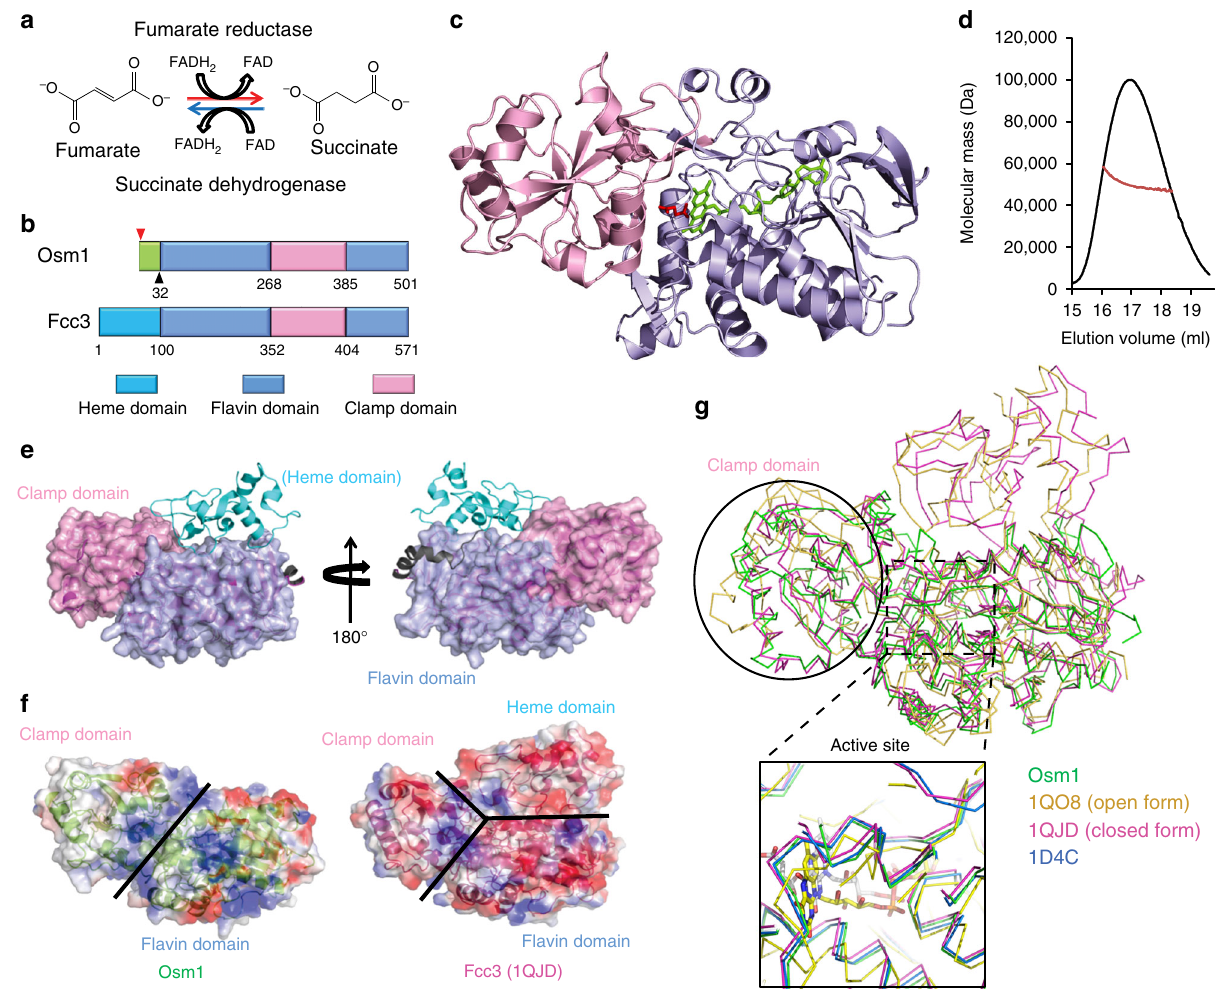
Fig. 1 Crystal structure of Osm1 in a complex with the FAD cofactor and substrate. a Schematic of the enzymatic reaction catalyzed by fumarate reductase. b Domain structure of Osm1 and a representative soluble fumarate reductase, Fcc3, from Shewanella frigidimarina . The individual domains are indicated by different colors, as shown. The Osm1 construct containing residues 32 – 501 used in the current structural study is indicated by the black triangles. The two different translational start sites, M1 and M33, are indicated by the arrows. ER endoplasmic reticulum, Mt mitochondria. c Ribbon diagram of the structure of Osm1 in a complex with FAD and substrate. Two distinct domains are shown with light blue for the fl avin domain and light pink for the clamp domain. Bound FAD and substrate are shown in green and red, respectively. d Multi-angle light scattering (MALS) measurement of Osm1 in a complex with FAD and substrate. The x -axis and y -axis indicate the elution volume and molecular mass, respectively. e Comparison of the active site and the FAD-binding site of Osm1 with other Fcc3 structures. The color codes are indicated. f Comparison of the Osm1 structure with a representative structural homolog by superposition of Osm1 with Fcc3 from S. frigidimarina . The clamp domain and the fl avin domain are indicated in light blue and pink, respectively. The heme domain found only in the Fcc3 family is indicated in green. g Electrostatic surface representation of both Osm1 and Fcc3 from S. frigidimarina . The domain boundaries are indicated by black